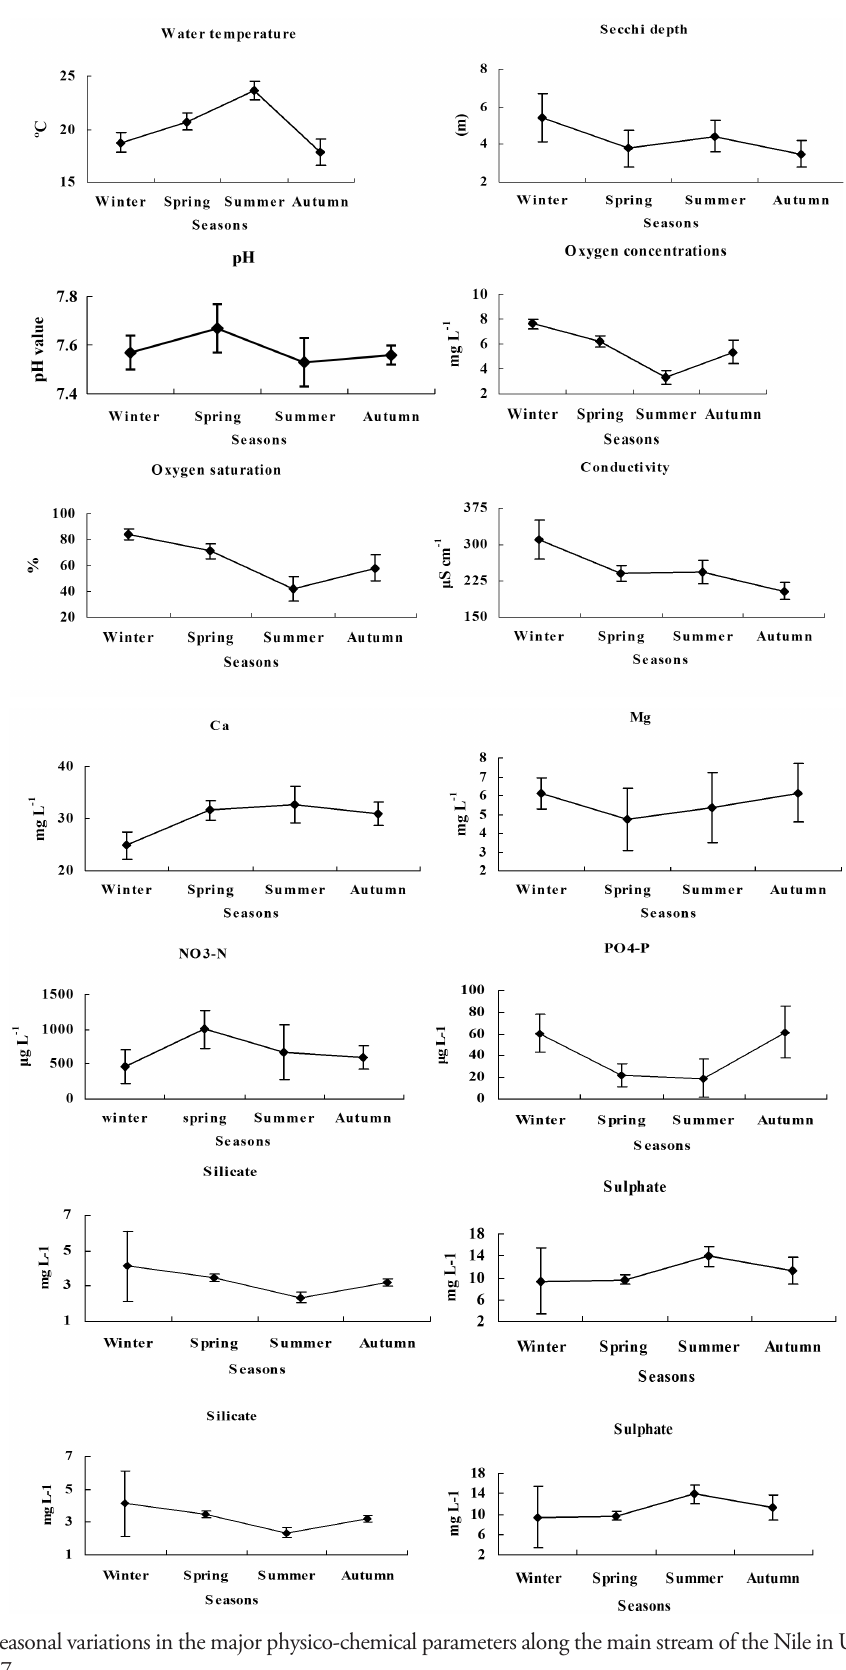
Figure 2. Seasonal variations in the major physico-chemical parameters along the main stream of the Nile in Upper Egypt during